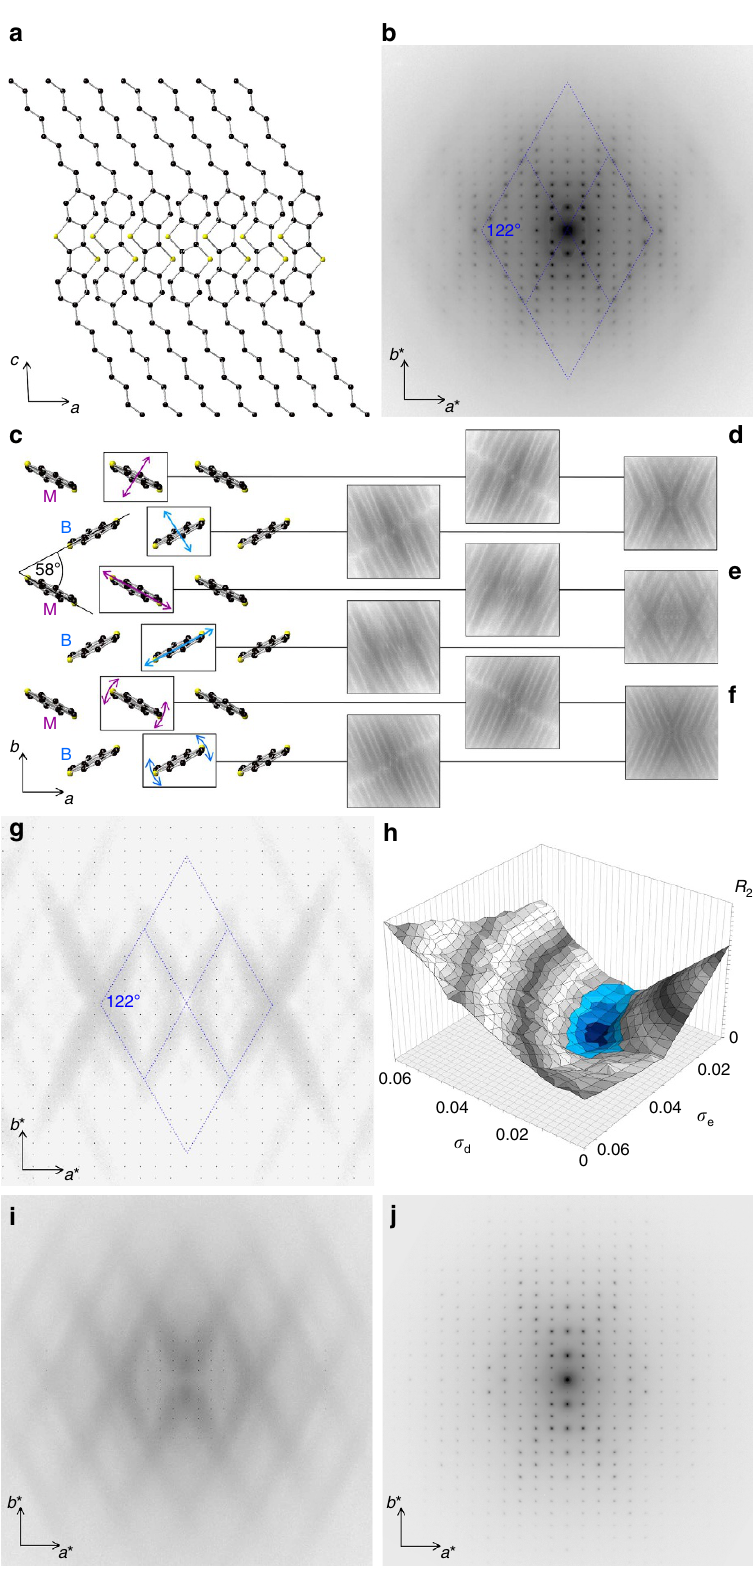
Figure 2 | Structure of C8-BTBTand streak formation of different thermal modes with refinement. ( a ) Cross-sectional view of the C8-BTBT structure. ( b ) Experimental diffraction pattern of C8-BTBT. ( c ) Top view of the C8-BTBTstructure. Hydrogens and side chains are omitted for clarity. Simulation of the diffuse features for selected vibrations, first for molecules of each orientation R and G separately, then combined ( d – f ). ( g ) Simulated diffraction pattern that only incorporates the vibrational modes ( d , e ). ( h ) Discrepancy of the simulated and experimental diffraction data expressed as the least square residual for different amplitudes for vibrations ( d , e ). ( i ) Simulated diffraction pattern based on MD simulation. ( j ) Experimental diffraction pattern of C8- BTBT taken at